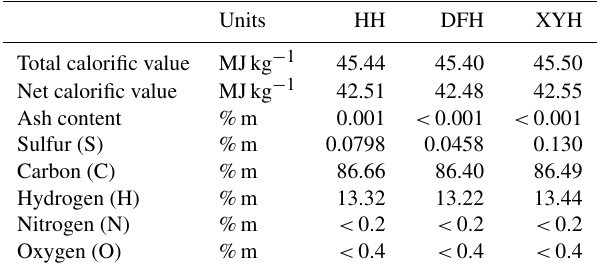
Table 2. Results from the fuel analysis